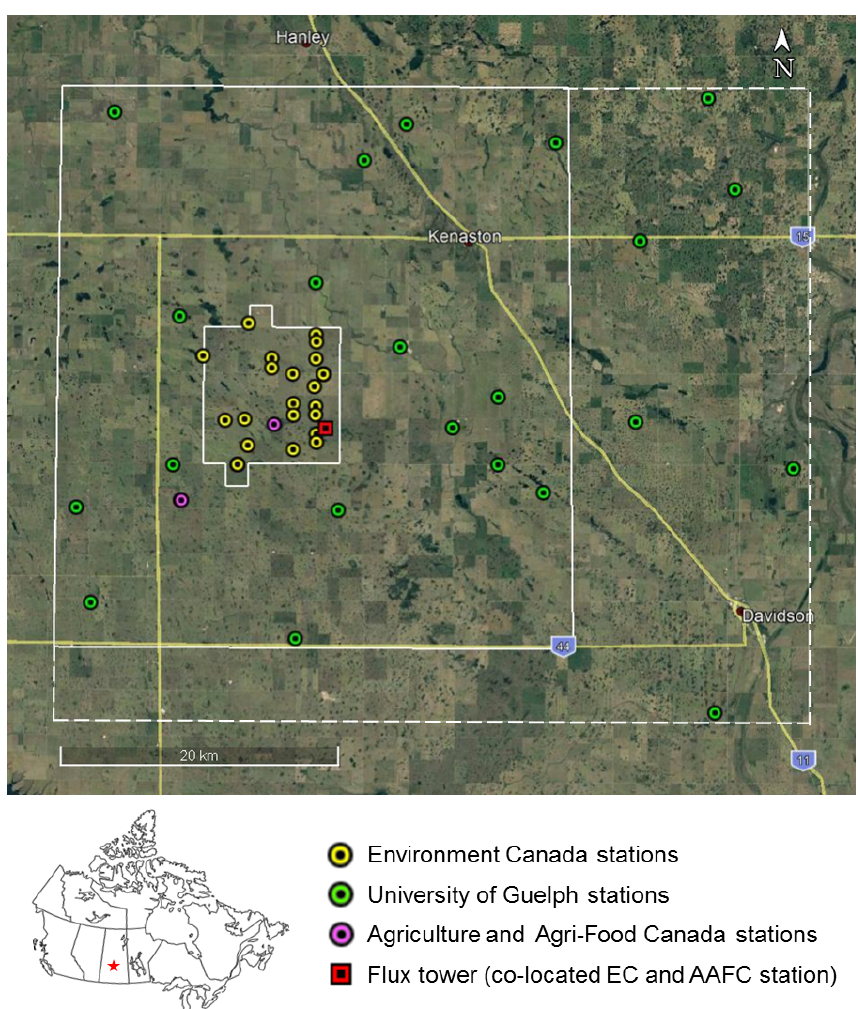
Figure 1. Map of site locations, with the white frames indicating the two scales of the sites. ECCC sites are within a 10km × 10km area and University of Guelph sites are within the current 40km × 40 km area. The dashed line indicates the original larger scale: 45km by